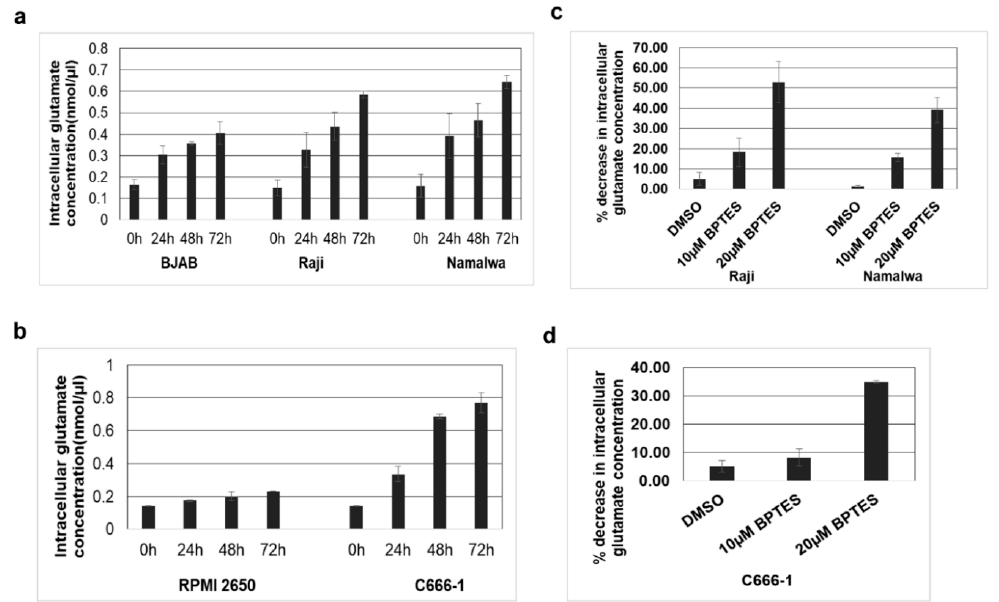
Figure 6. KGA and GAC expression increase intracellular glutamate levels. ( a ) EBV-negative cell line BJAB and EBV-positive cell lines Raji and Namalwa were cultured and intracellular glutamate concentration was determined in the cell lysates collected at various time points using glutamate assay kit. ( b ) Intracellular glutamate concentration in the cell lysates collected at various time points from EBV-negative cell line RPMI 2650, and EBV-positive cell line C666-1. Glutamate concentration is expressed in nanomoles per microliter. ( c , d ) Namalwa, Raji, and C666-1 cell lines were treated with control DMSO or with two di ff erent concentrations of BPTES 10 µ M and 20 µ M for 72 h. Intracellular glutamate concentration was determined in the lysates collected after 72 h. Graphs represent the percentage decrease in intracellular glutamate concentration in Raji, Namalwa ( c ) C666-1 ( d ) Error bars represent the mean ± SD of two independent